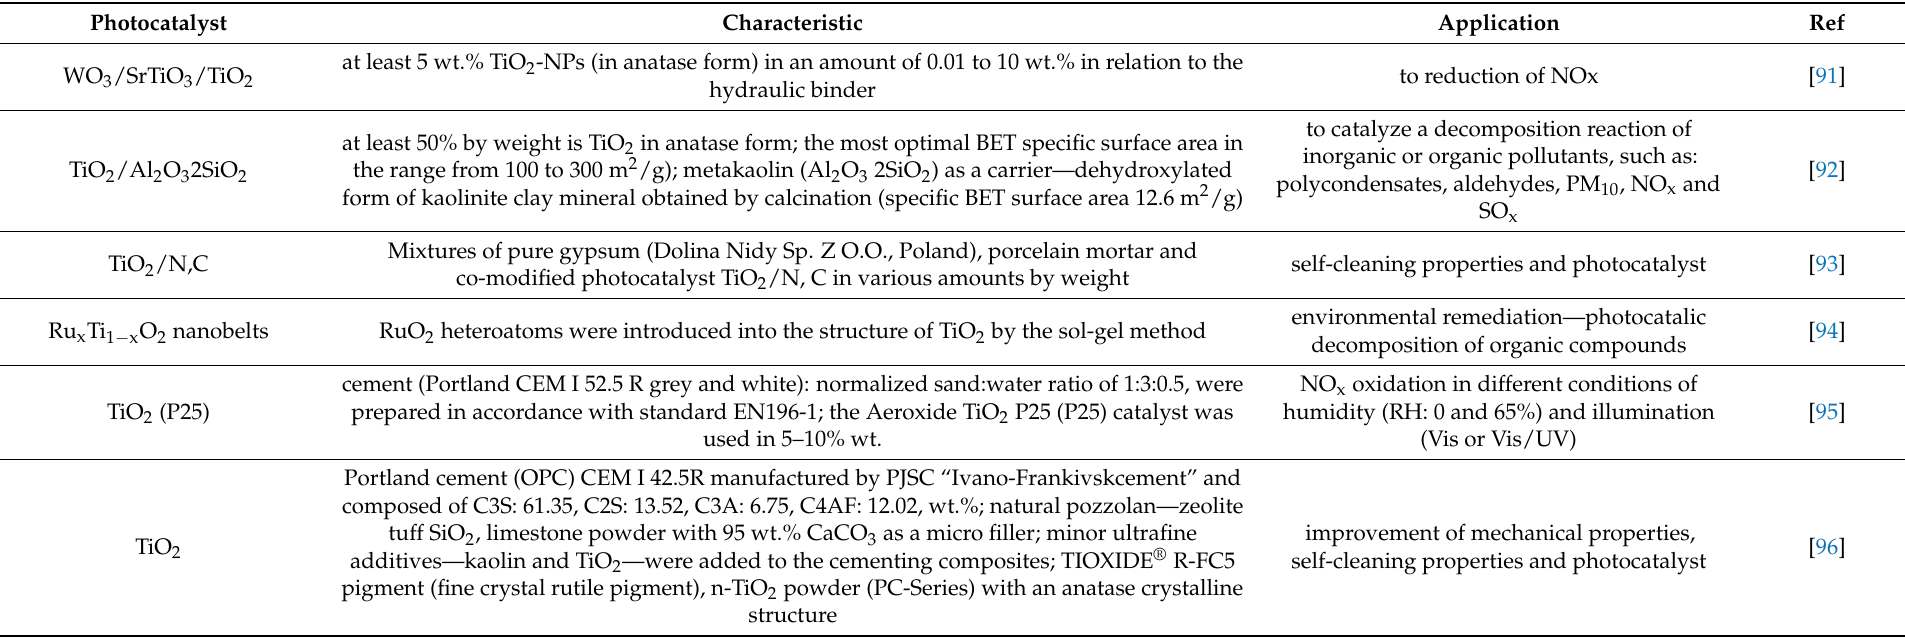
Table 2. Examples of selected photocatalysts used in building materials to reduce